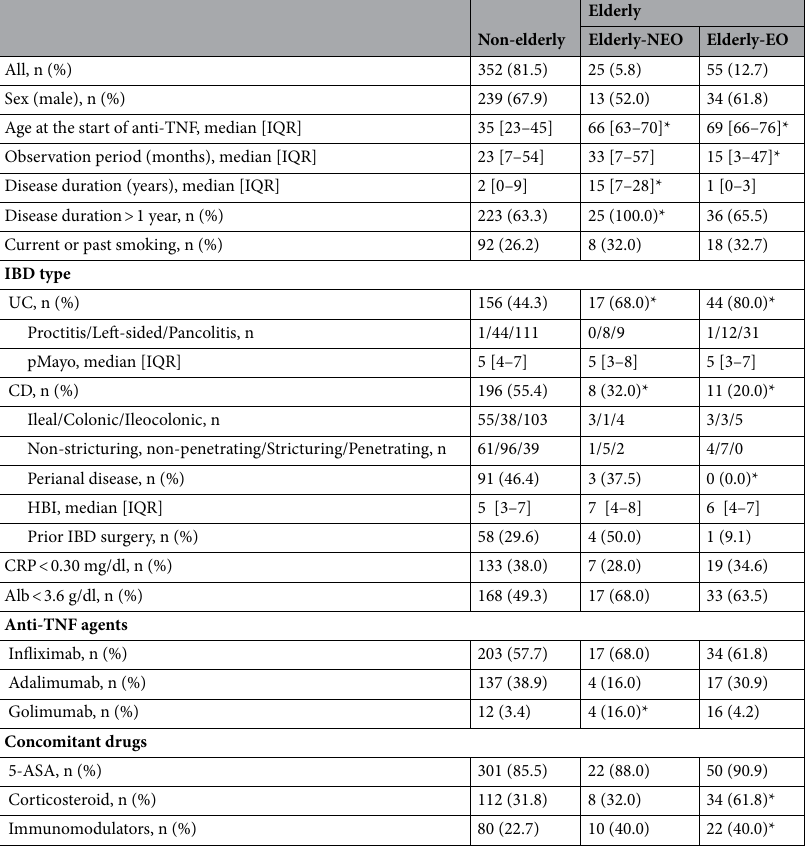
Table 1. Baseline characteristics and concomitant drugs at the start of anti-TNF treatment. Alb Albumin, anti-TNF anti-tumor necrosis factor, 5-ASA 5-aminosalicylate, CD Crohn’s disease, CRP C reactive protein, EO elderly onset, HBI Harvey-Bradshaw Index, IBD inflammatory bowel disease, IQR interquartile range, NEO non-elderly onset, pMayo partial Mayo score, UC ulcerative colitis, * P value < 0.025 compared with Non- elderly.